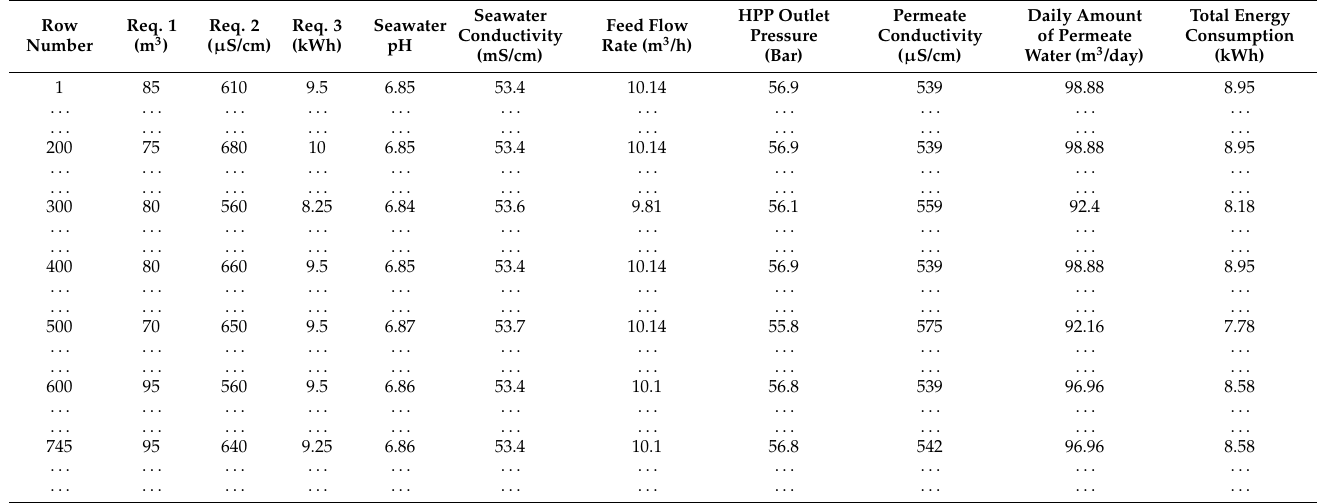
Table 4. Sample of the table of optimal values.